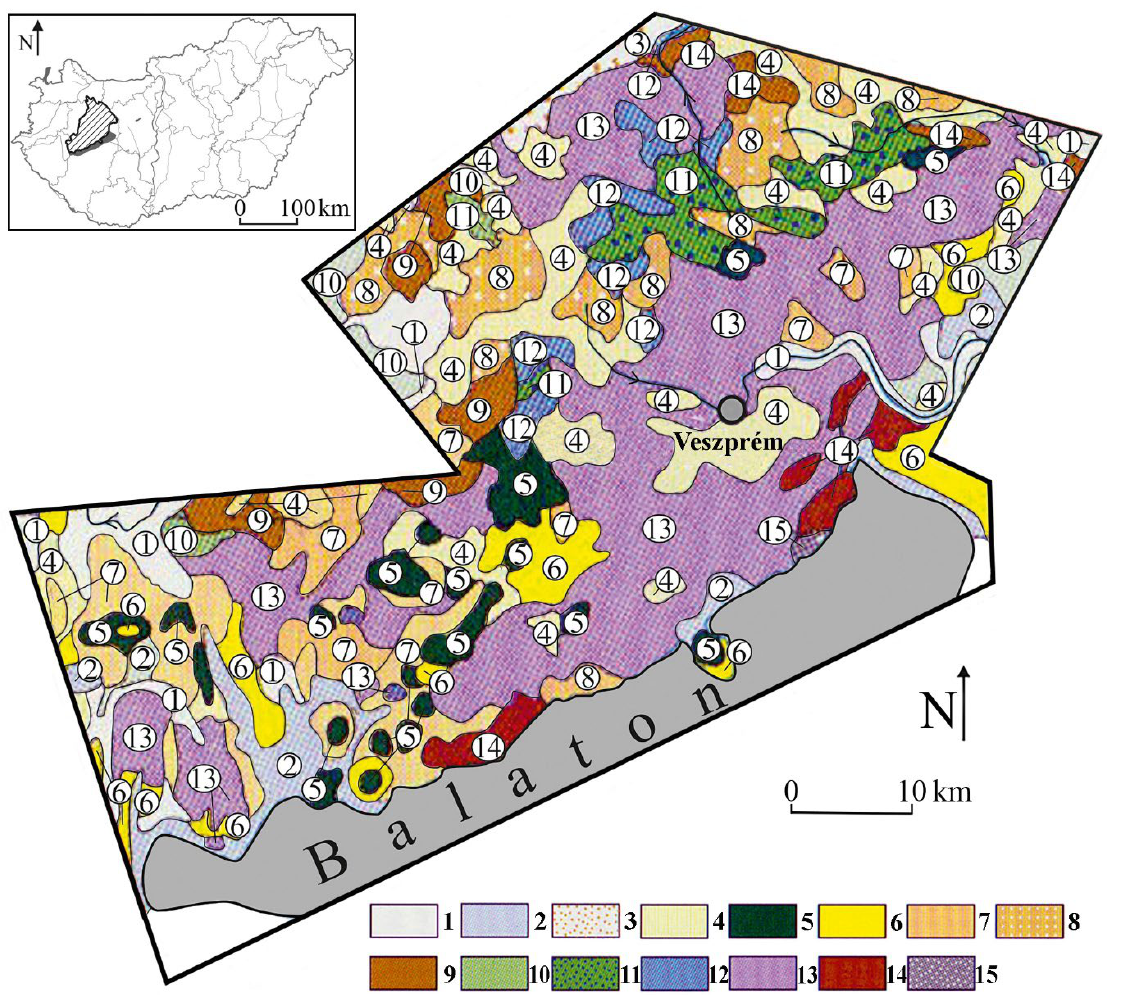
Figure 2. Geological map of the Bakony Region [17]. Legend: 1. fluvial sediment, 2. Holocene peat, 3. Holocene wind-blown sand, 4. Pleistocene loess, 5. Pliocene basalt, 6. Upper-Miocene freshwater limestone, 7. Middle Miocene limestone, 8. Oligocene gravel, 9. Eocene limestone, 10. Upper Cretaceous limestone, 11. Lower Cretaceous limestone, 12. Jurassic limestone, 13. Triassic limestone, dolomite, 14. Permian sandstone, 15. old Paleozoic phyllite.